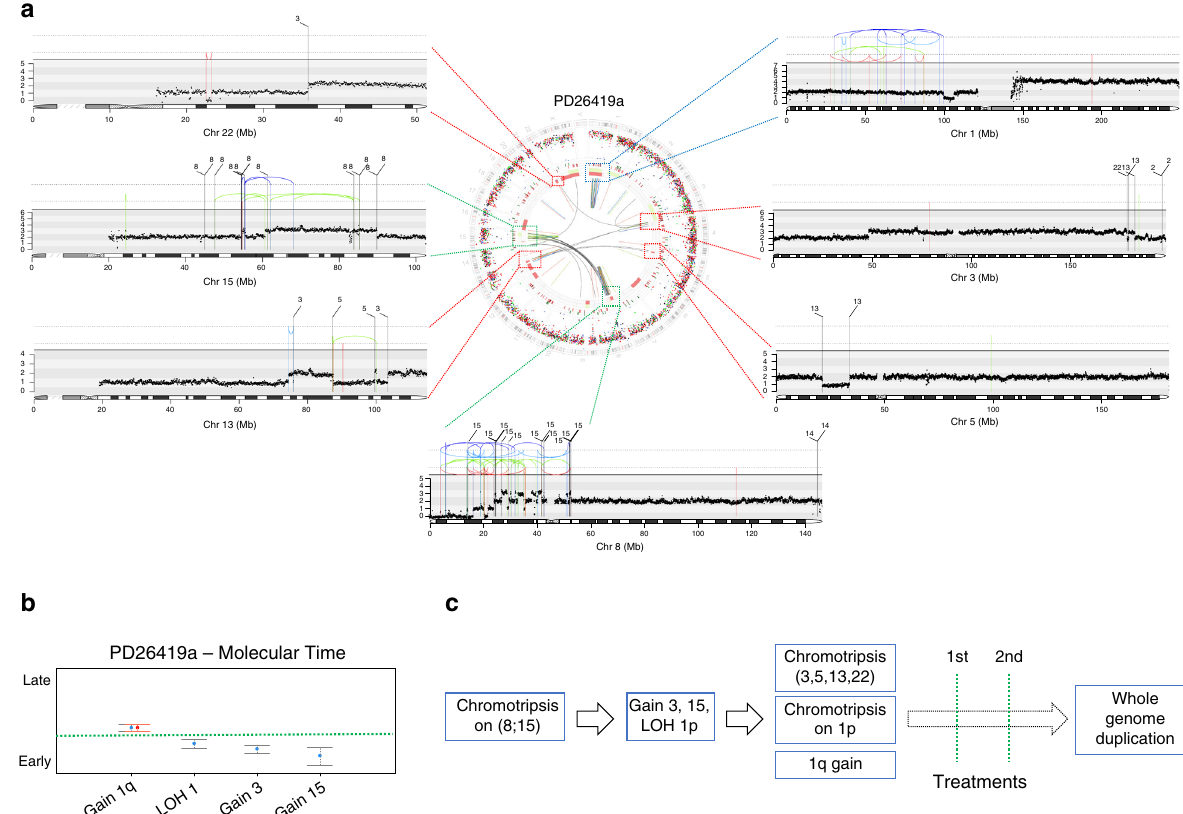
Fig. 5 De fi ning the relative order of acquisition of the key driver events. a Genome plot of patient PD26419a where the three chromothripsis events [(8;15), (3;5;13;22) and 1p] were highlighted with different colored dashed lines connected to speci fi c rearrangements/copy-number plots. In these plots, the red arch represents a deletion, the green arch represents an ITD and the blue arch represents an inversion. b Molecular time of the main clonal gains and CN- LOH in the PD26419a sample. This data suggested the existence of at least two independent time windows: the fi rst involving alterations on chromosomes 3, 15, and 1p and the second chromosome 1q. c The driver events of patient PD26419 are reconstructed in chronological